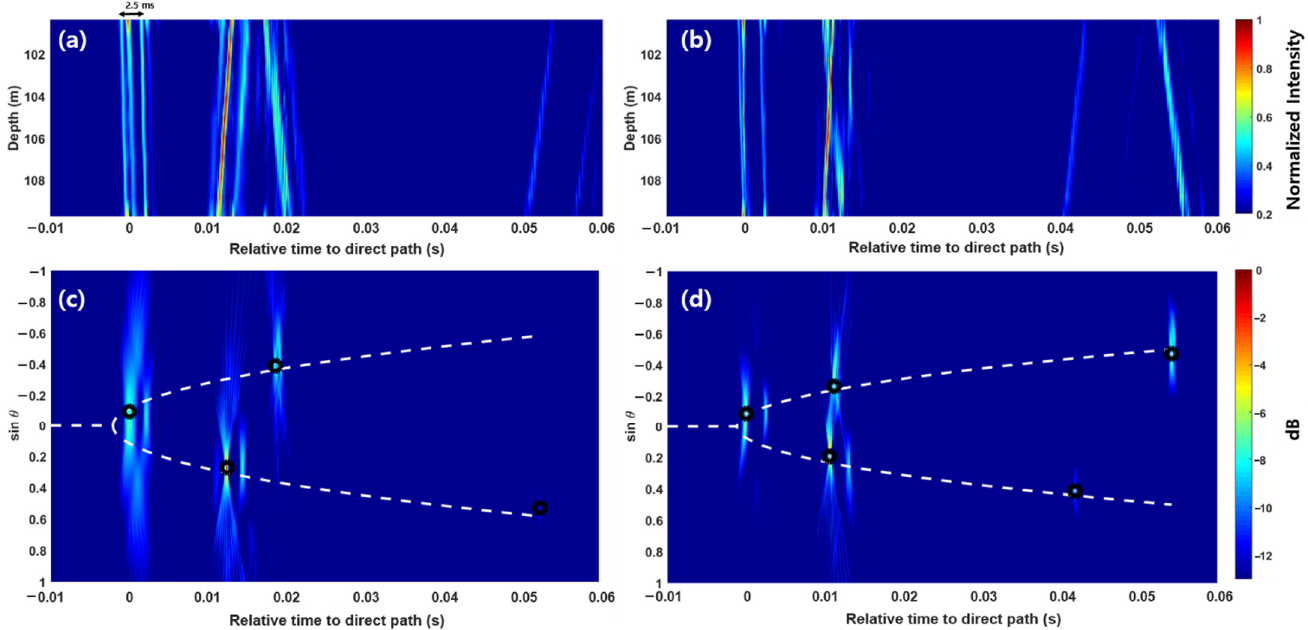
Figure 8. Channel impulse responses (CIR) measured at the vertical line array with 11 elements spanning a 9.38 m aperture for source–receiver ranges of ( a ) 460 m and ( b ) 637 m. Estimated beam-time migration (black circle) and the best-fit elliptic curve solution (white dashed line) for source–receiver ranges of ( c ) 460 m and ( d ) 637 m. The time difference between the first and third peaks in the first arrival group in ( a ) corresponds to the time difference between the first and second positive peaks of bubble pulses.